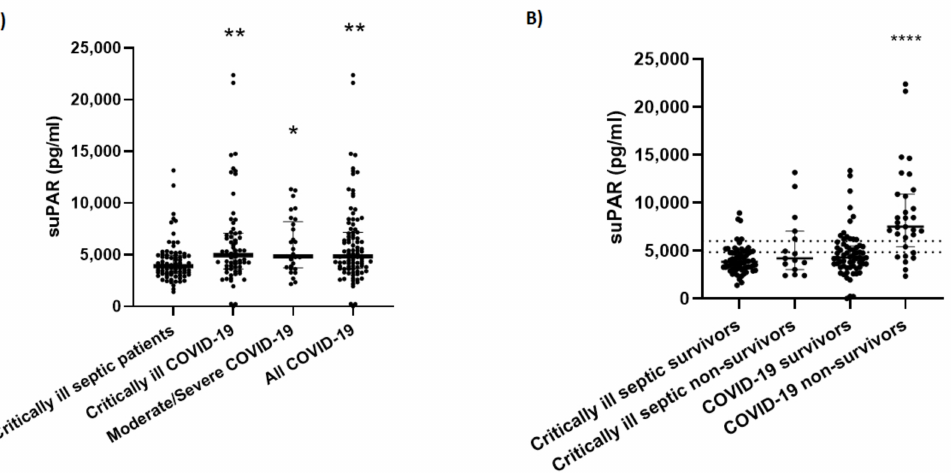
Figure 1. suPAR levels in COVID-19 and sepsis. ( A ) suPAR levels were measured on admission (within 24 h) in 66 critically ill and 29 moderate/severe COVID-19 patients, and 79 critically ill non- COVID-19 septic patients (within 6 h from sepsis diagnosis); ( B ) The COVID-19 and non-COVID-19 septic patients were divided in survivors and non-survivors, and their suPAR levels were compared. Horizontal lines, medians of the two groups. The groups were compared by ANOVA followed by Kruskal-Wallis (panel A, p -values against the septic group), or Mann-Whitney (panel B, between survivors and non-survivors within each group). * p < 0.05, ** p < 0.01, **** p < 0.0001. suPAR = soluble urokinase-type plasminogen activator